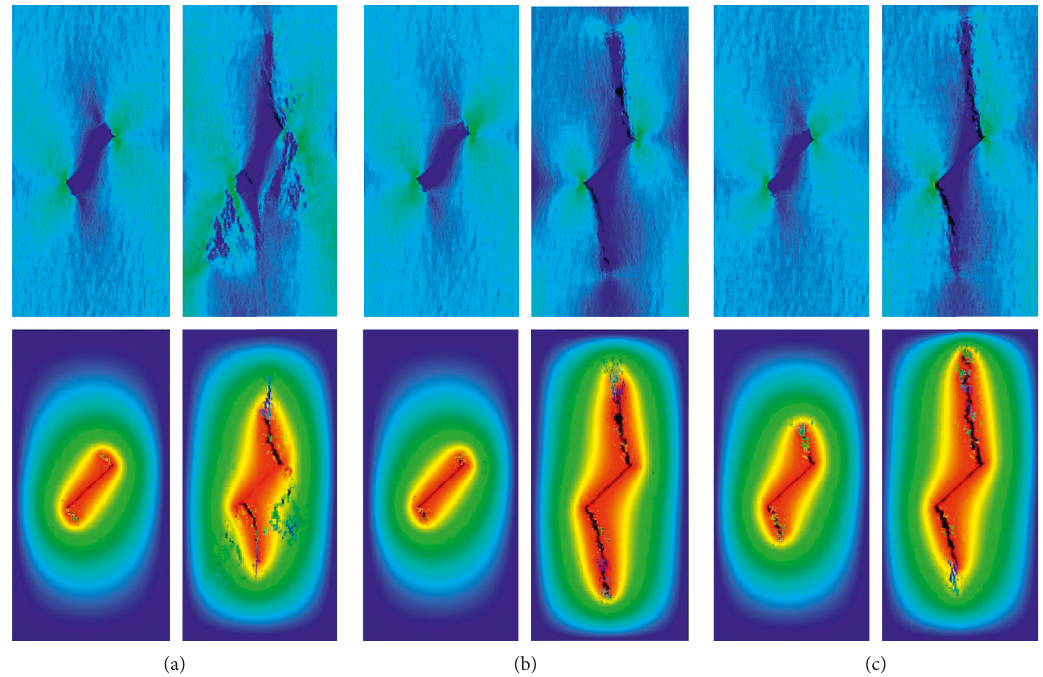
Figure 8: Maximum shear stress (upper) and pore pressure (lower) evolution diagram of different pore pressures when σ � 3.0MPa. (a) P � 1.0MPa, σ � 3.0MPa; (b) P � 1.5MPa, σ � 3MPa; (c) P � 1.8MPa, σ � 3MPa.